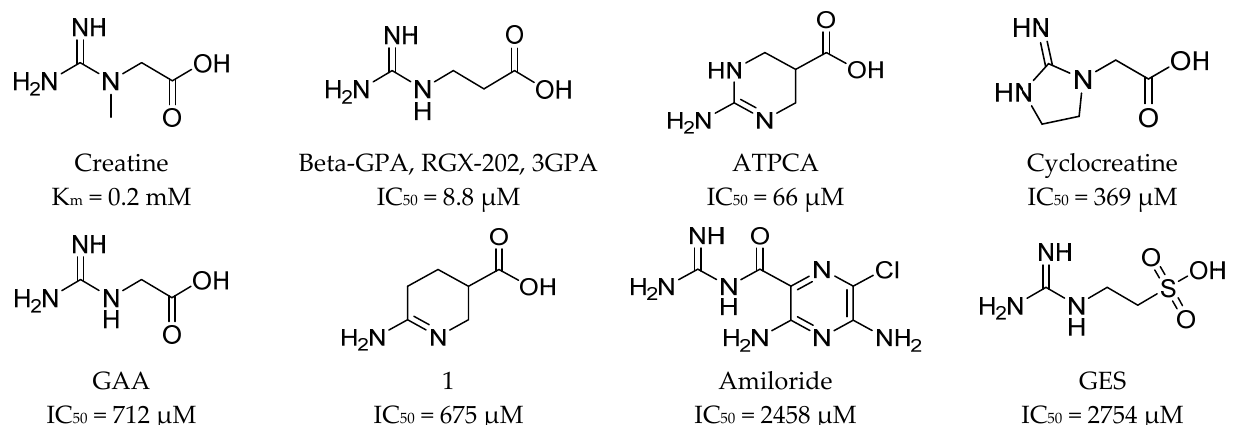
Figure 6. Creatine analogues tested against SLC6A8 transporter. Biological activity of compounds is expressed as IC 50 values [70,72,73].